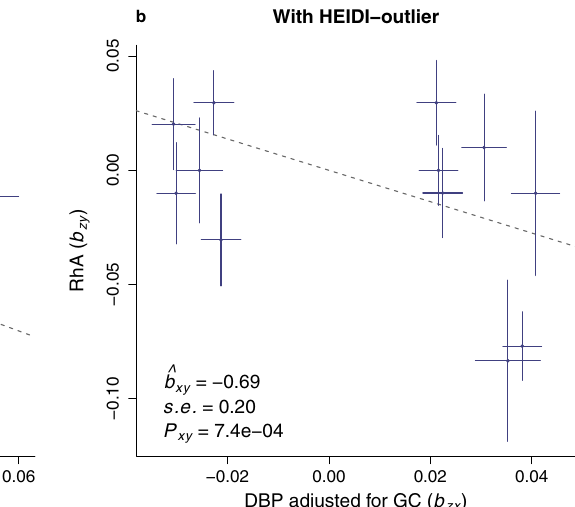
adjustedforGCwasconductediniPSYCH2012.DetailsofGWASsummarystatistics for MS and RhA are provided in Methods. No pleiotropic SNPs were identi fi ed by HEIDI-outlier for these two disorders. The bar shown in the graph represents the GWAS standard error for each SNP with its center being the GWAS effect of SNP. The Bonferroni-corrected threshold was 1.9×10 − 3 (=0.05/(13×2).